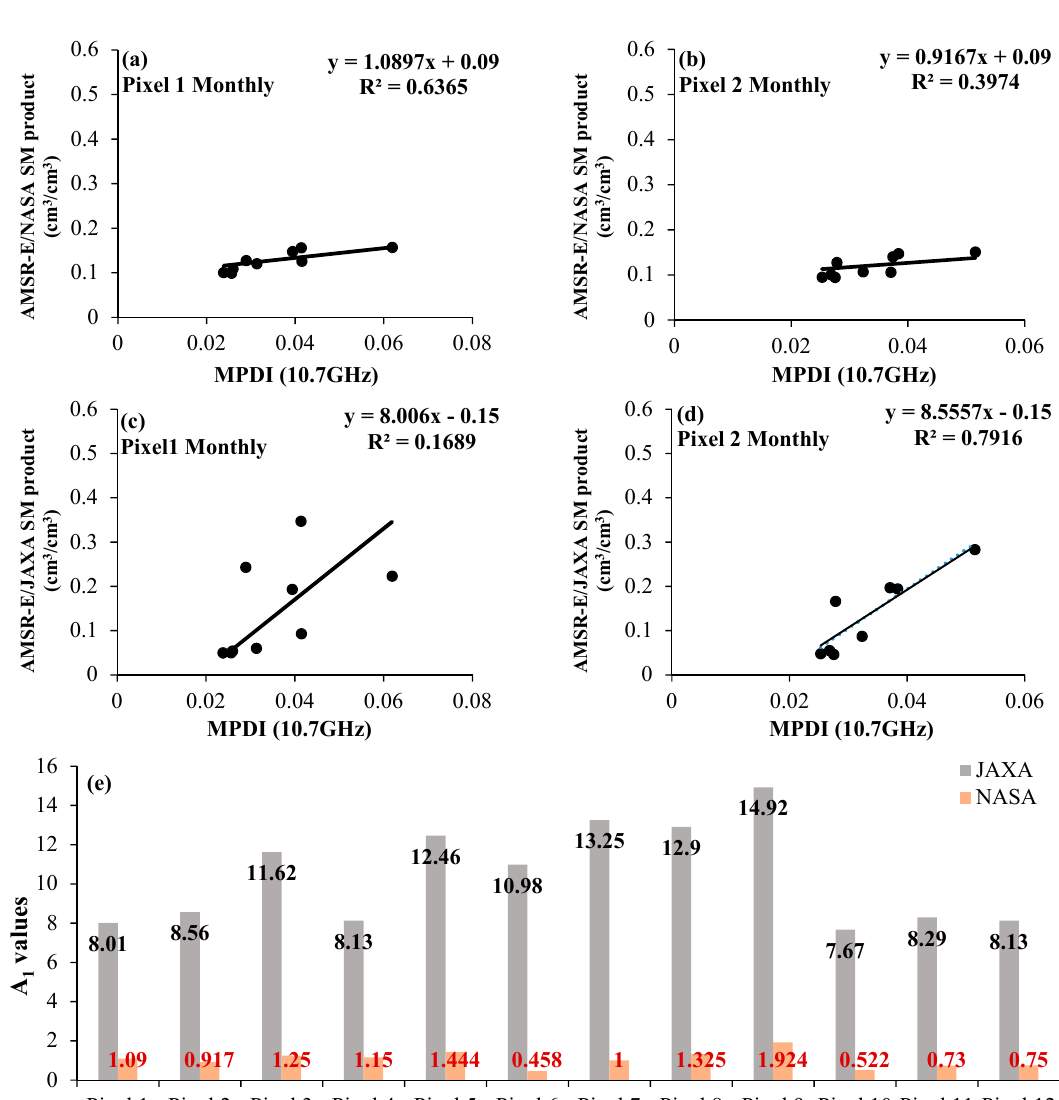
Figure 11. Relationships between the monthly AMSR-E / NASA and JAXA SM values and monthly MPDI in pixels 1 through 12, Naqu area in 2011; ( a ) NASA SM Pixel 1; ( b ) NASA SM Pixel 2; ( c ) JAXA SM Pixel 1; ( d ) NASA SM Pixel 2; ( e ) the A 1 coefficient values.